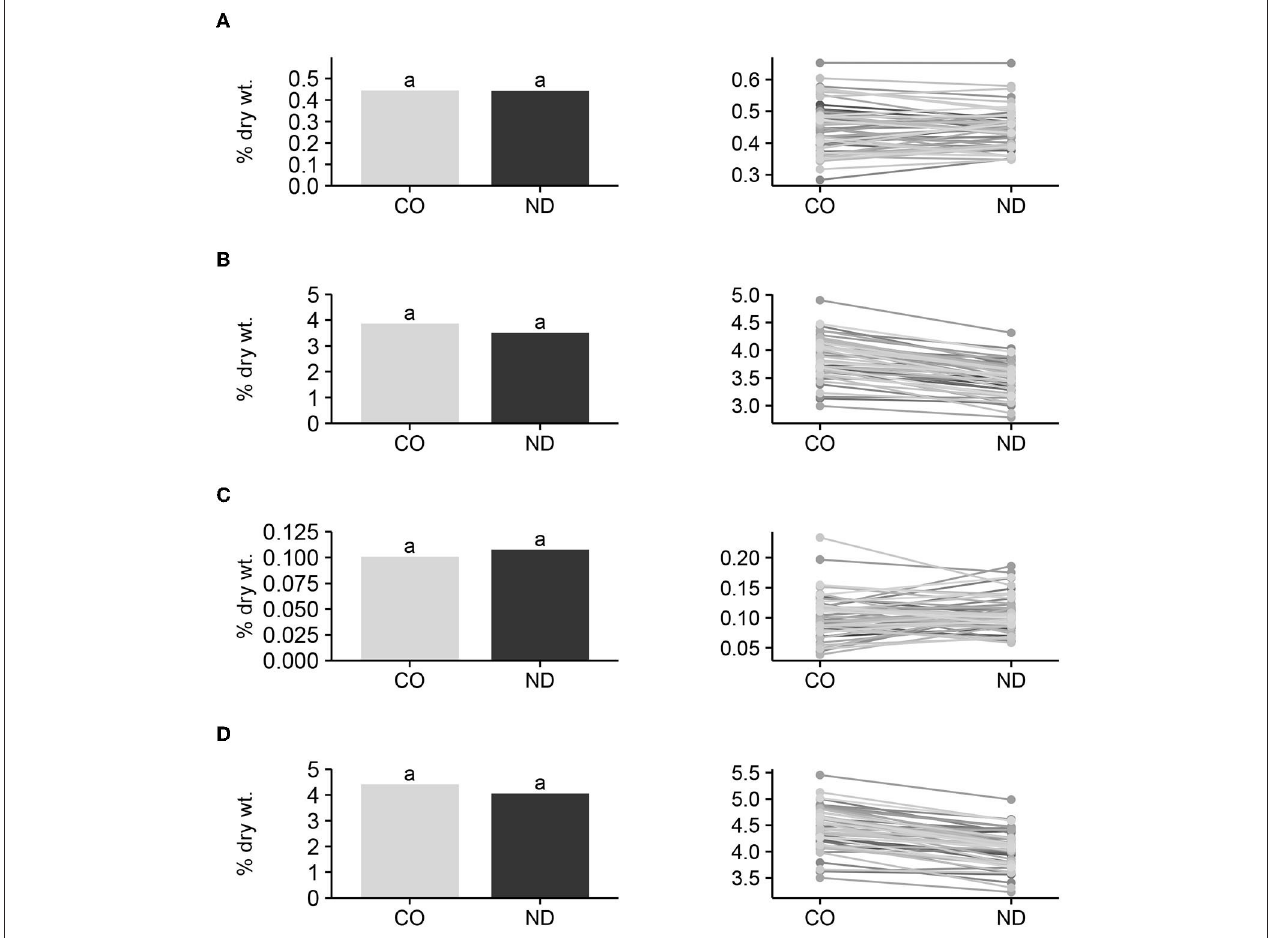
FIGURE 2 | Mean raffinose (A) , stachyose (B) , verbascose (C) , and total oligosaccharide (D) content among entries ( n = 57) grown in Colorado (CO) and North Dakota (ND), and graphic response of content among entries over locations. Bars with the same lowercase letter are not significantly ( P ≤ 0.05) different between